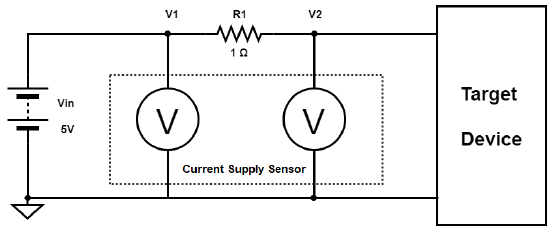
Figure 3. Circuit of the monitoring